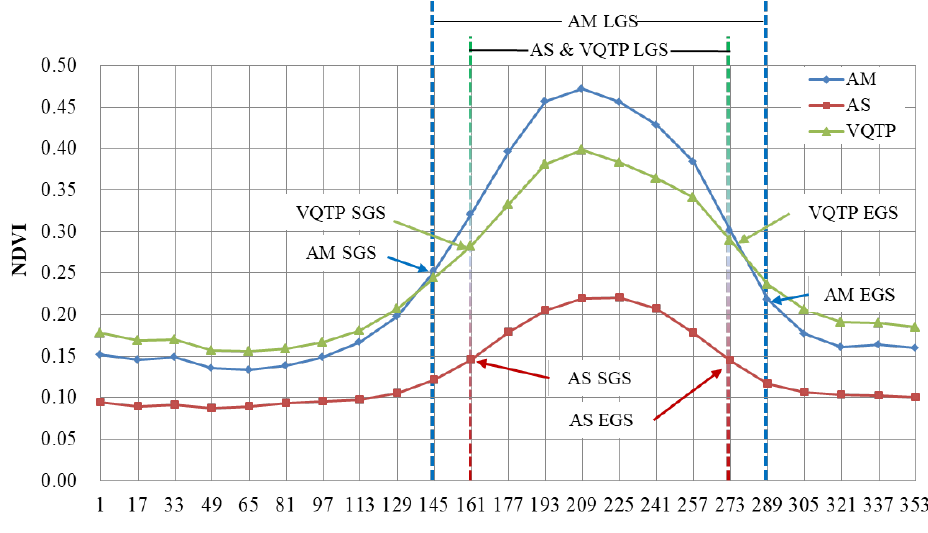
Figure 3. Comparison of phenological parameters (SGS, EGS and LGS) of the AM, AS and VQTP based on the 16-day NDVI time series. SGS, start of the growing season; EGS, end of the growing season; LGS, length of the growing season; AM, alpine meadow; AS, alpine steppe; VQTP, overall vegetation of the Qinghai-Tibetan Plateau.